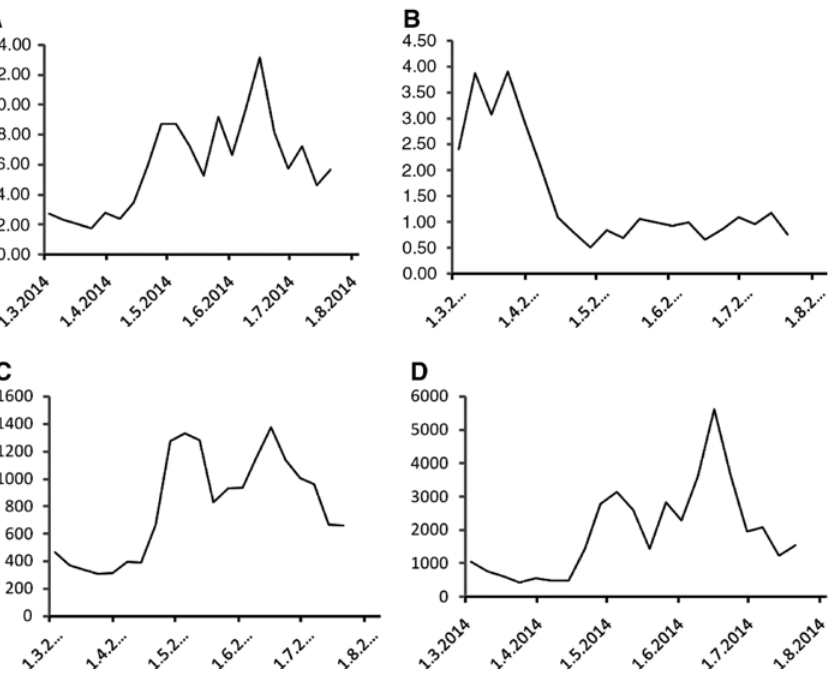
Figure 4: Peripheral blood cell count-derived ratios during the course of treatment. (A) The neutrophil-to-lymphocyte ratio, (B) the lymphocyte-to-monocyte ratio, (C) the platelet-to-lymphocyte ratio and (D) the systemic inflammatory index determined in weekly intervals during the course of